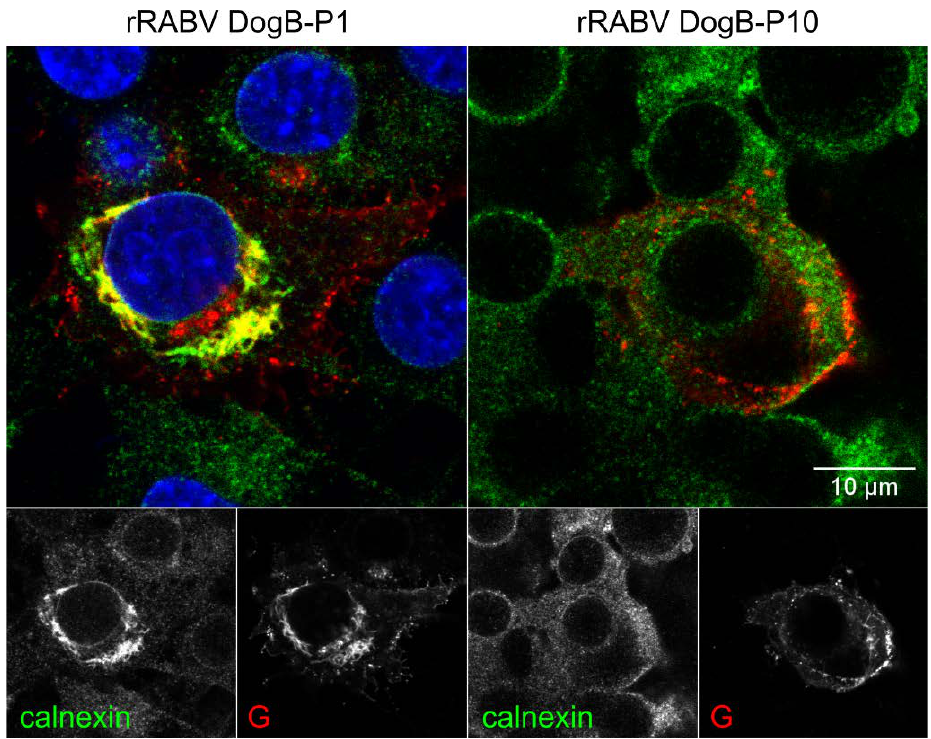
Figure 4. G protein retention in the endoplasmatic reticulum (ER). Immunofluorescence staining of RABV G (red) and the ER marker calnexin (green) in BHK cells at 1 dpi underlines an accumulation of G within the ER for the P1 virus. A loss of ER localization is observed following the serial passaging in rRABV DogB-P10-infected cells. Blue: Hoechst 33342.